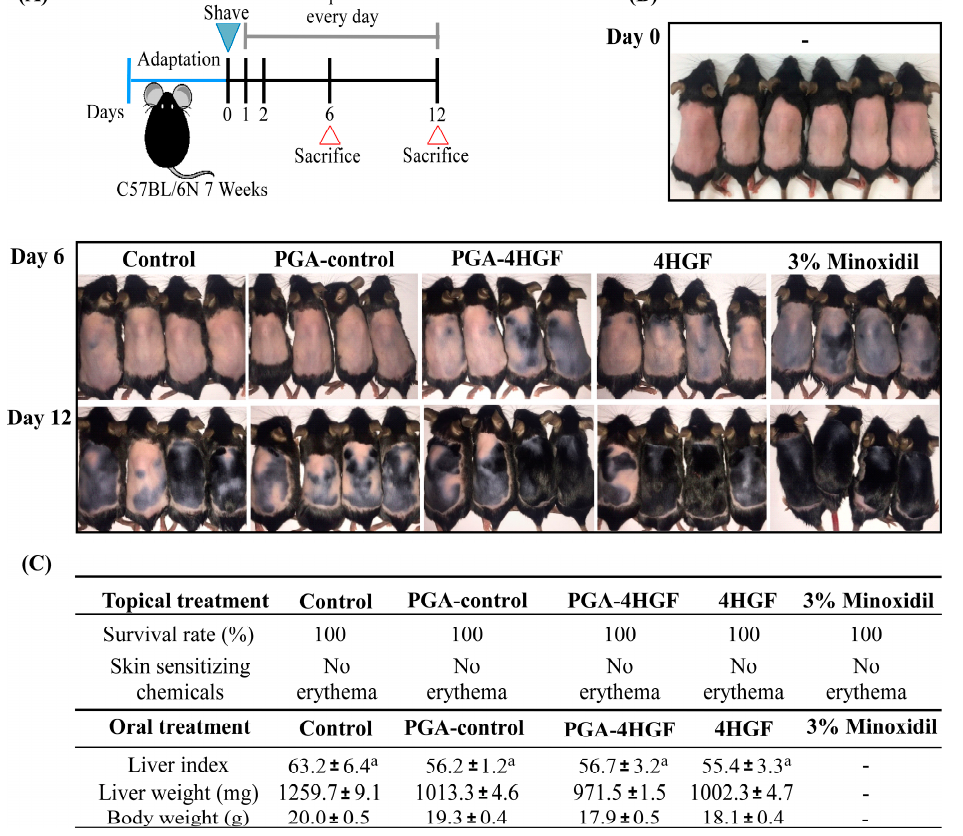
Figure 3. Hair-growth-promoting effects of PGA-4HGF in telogenic C57BL/6N mice. ( A ) The design of animal experiments using C57BL/6N telogenic murine models. At day 0 which a blue triangle is pointed, a 3 × 4 cm 2 area of dorsal skin of all the mice were shaved. At day 6 and 12, which red triangles are pointed, the mice were sacrificed. ( B ) Dorsal skins were photographed on day 1 and 12. The images are representative pictures of the mice ( n ≥ 6/group). ( C ) Survival rate of C57BL/6N telogenic murine models with PGA-4HGF topical treated during total animal experiments ( n = 2). After PGA-4HGF treatment for 12 days in the C57BL6/N model, the analysis of the skin erythema status according to the standards announced by the Korea Food and Drug Administration. Body and liver weight of mice subjected to distilled water (control) gavage or PGA-4HGF Gavage. Data were analyzed with one-way ANOVA/Duncan’s t -test ( p < 0.05). Each mean with a is not significantly different.